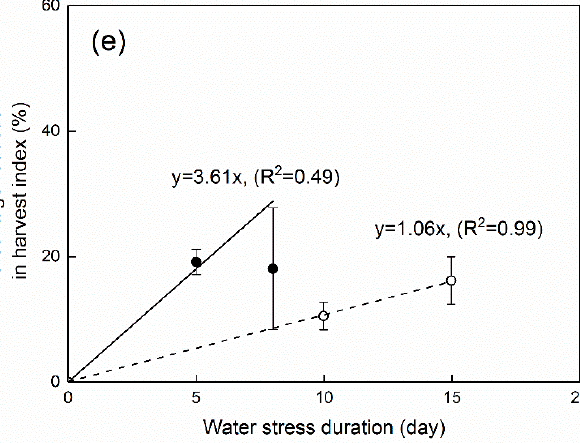
Figure 4. The yield-reducing rates of flood alone and drought alone on seed cotton yield ( a ), dry matter yield ( b ), boll number ( c ), boll hull mass ( d ), and harvest index ( e ). In each subgraph, two solid dots (●) represent the average yield indices under two flood treatments, respectively; two hollow dots ( ○ ) represent the average yield indices under two drought treatments, respectively. Error bars show standard errors. The displayed regression equations are derived by using weighted least square regression method, which is capable for accounting for di ff erent error variations of di ff erent treatments. Bars without standard errors means there is no error or the error is near to zero.